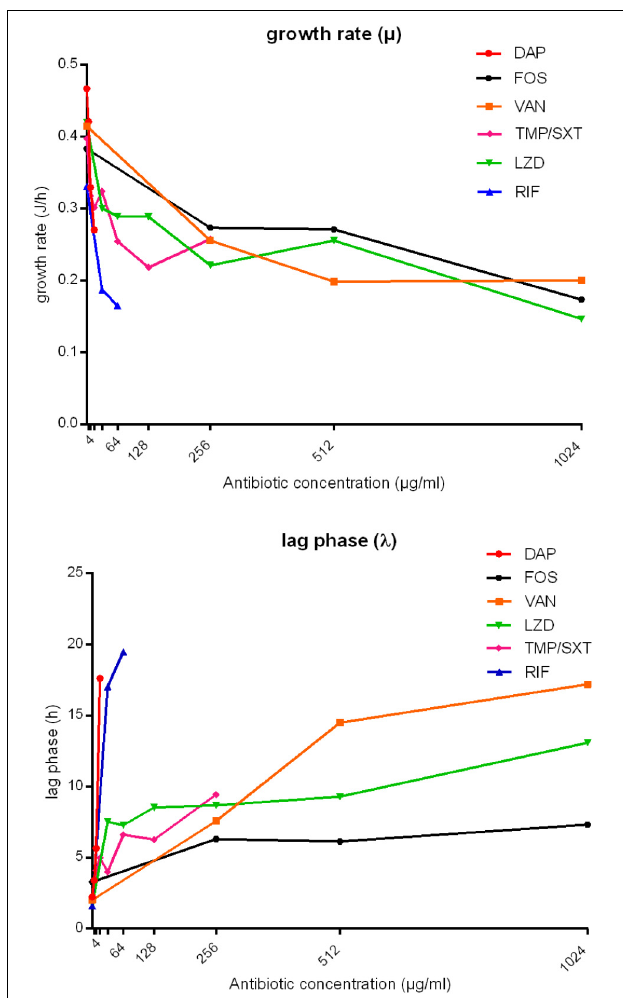
FIGURE 4 | Analysis of growth rate ( µ , J/h) and lag phase ( λ , h) obtained from IMC data of MRSA biofilm treatment with daptomycin (DAP), fosfomycin (FOS), vancomycin (VAN), trimethoprim/sulfamethoxazole (TMP/SXT), linezolid (LNZ) and rifampicin (RIF). The bacterial growth rate ( µ , J/h) and the lag phase ( λ , h) are plotted against antibiotic concentrations ( µ g/ml). TMP/SXT concentrations are expressed as trimethoprim concentrations.